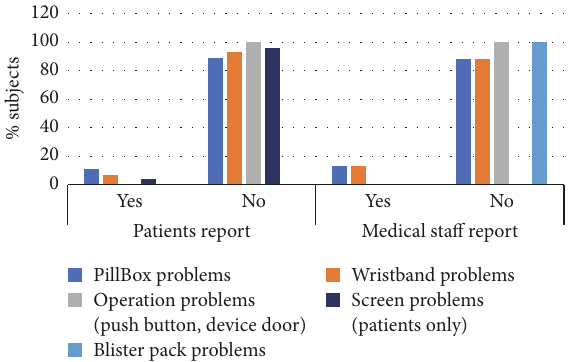
Figure 4: Summary of safety parameters of PCoA Acute. Both patients and medical staff were asked about occasions of 2 pills or damaged pill in PillBox. Only medical staff were asked for occasions of adverse events. Data was obtained from patients and medical staff questionnaires. Data from the PCoA Acute log files was used to confirm answers. NA: not applicable.